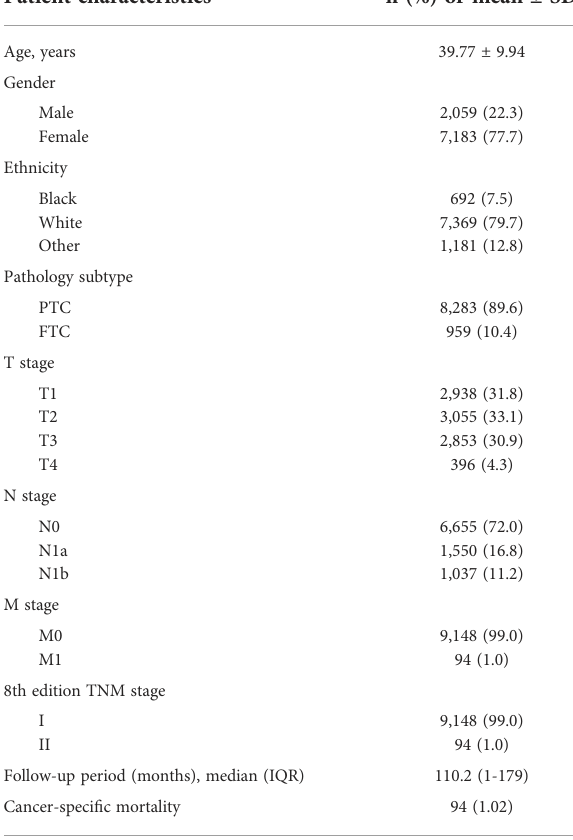
TABLE 1 The clinical characteristics of differential thyroid cancer patients.